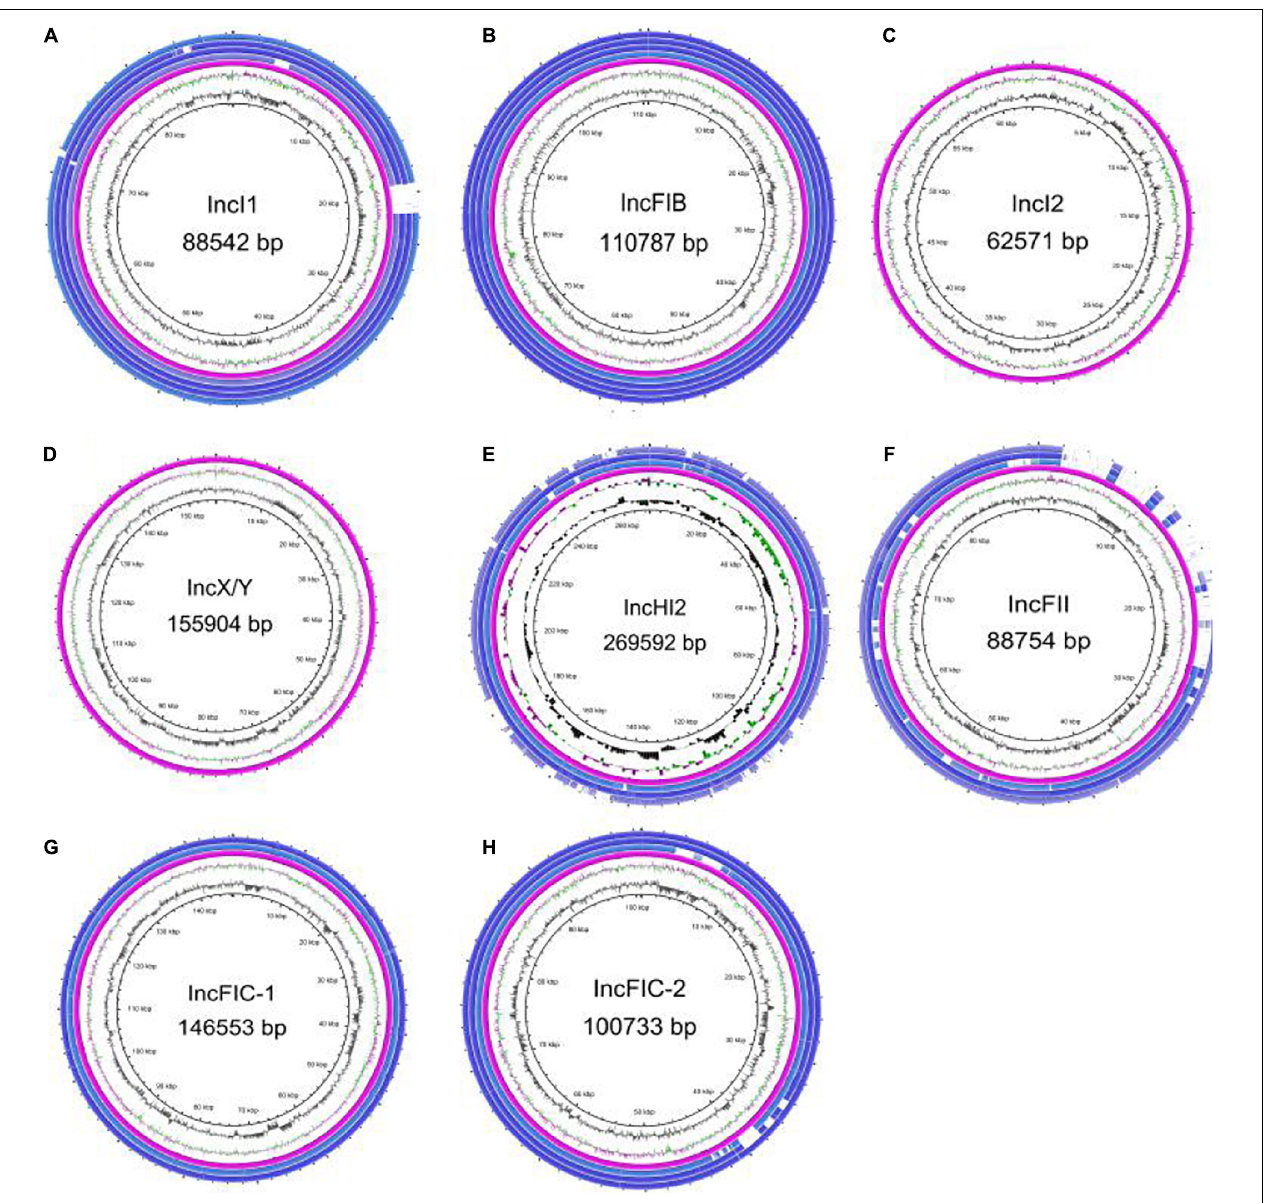
FIGURE 5 | Plasmid backbone comparison between different bla CTX − M − 55 -carrying plasmids. All types of plasmid circles were based on the known full-sequence plasmids as reference sequences from this study, and several isolates with the same type of plasmid were selected for drawing through BRIG. Among them, the IncI2 and IncX/Y plasmids contained only reference plasmids, and the IncFIC plasmid had two backbone types. (A) IncI1 plasmid. (B) IncFIB plasmid. (C) IncI2 plasmid. (D) IncX/Y plasmid. (E) IncHI2 plasmid. (F) IncFII plasmid. (G) IncFIC plasmid, the first backbone. (H) IncFIC plasmid, the second